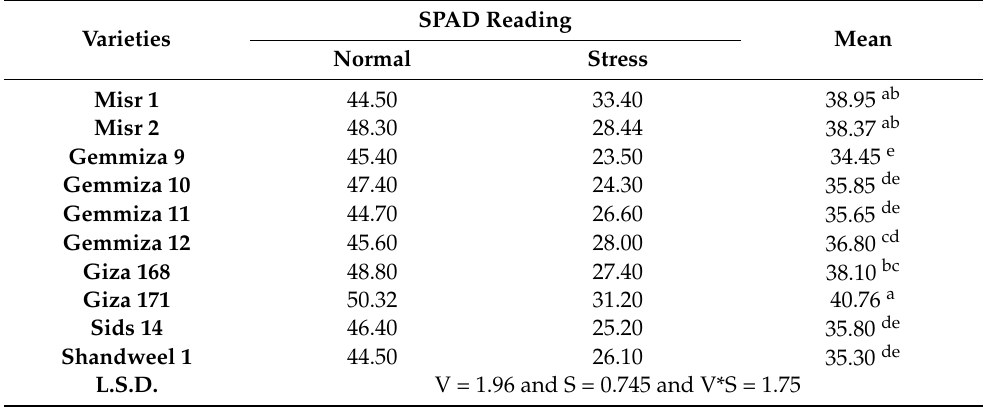
Table 3. Mean values of SPAD reading for ten wheat cultivars under normal and drought conditions. Different letters are significantly different, according to the LSD test, at p <